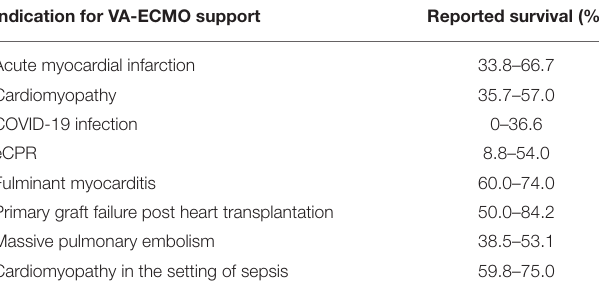
TABLE 2 | Outcomes of VA-ECMO support stratified by the initial cause of cardiogenic shock. Indication for VA-ECMO